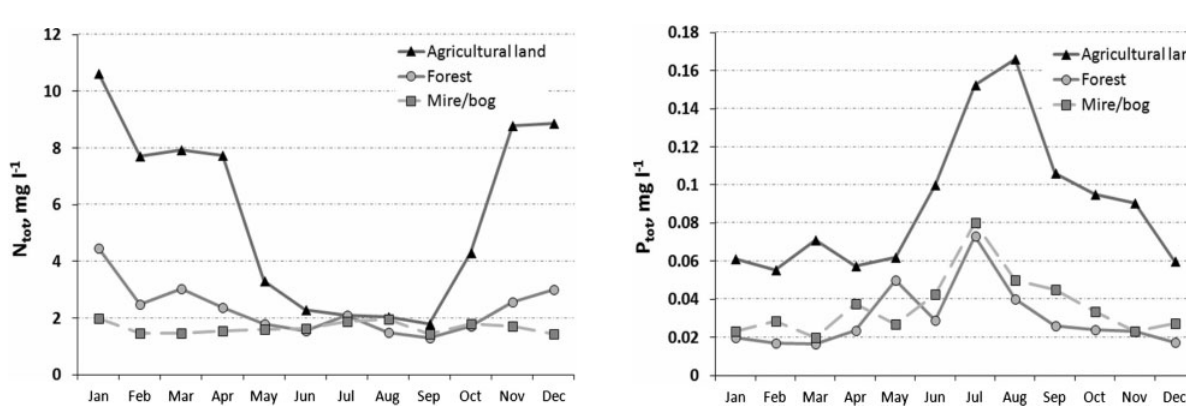
Fig. 5. Total phosphorus type-specific concentrations for diffuse source